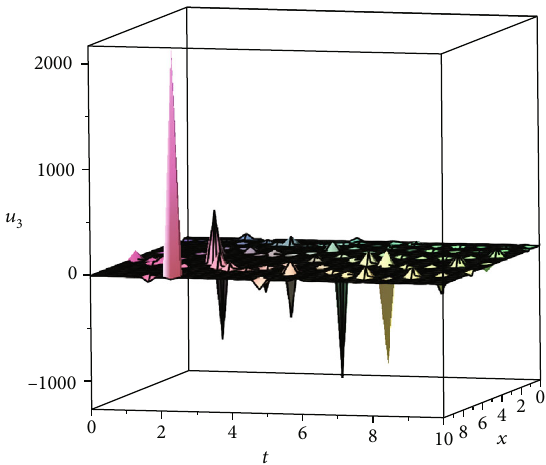
ð t , x Þ of Equation (24) for di ff erential 3